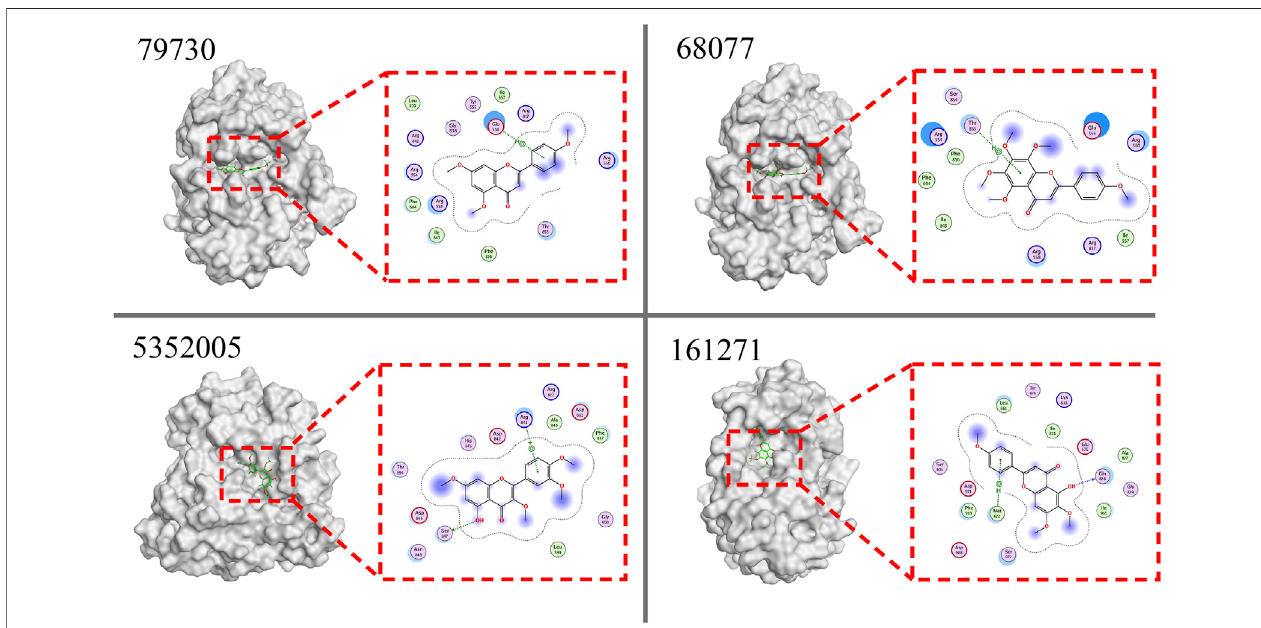
FIGURE 5 | Docking results of the top 4 compounds with PDGFRA. 79730, 68077, 5352005, and 161271 are PubChem CID of 4 ’ ,5,7-Trimethoxy fl avone, Tangeretin, Retusin, and Salvigenin, respectively. PDGFRA protein is shown as a white surface model, while the ligand is shown as a green stick model. The hydrogen bond is shown as the dotted lines. In the 2D interaction diagram, the ligand is shown as a chemical formula, the residues are shown in purple circles marked with their names, and the hydrogen bond is shown as the green dotted